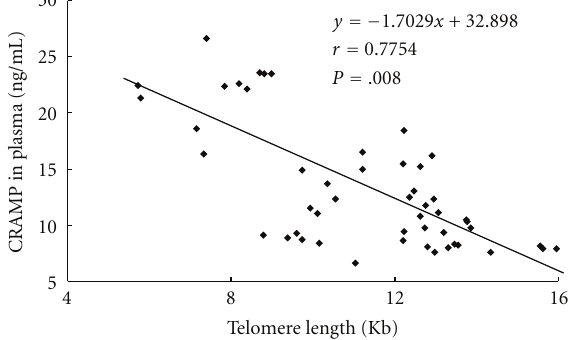
Figure 3: The relationship between telomere length and CRAMP level. There is the reverse correspondence between the telomere length and the plasma CRAMP